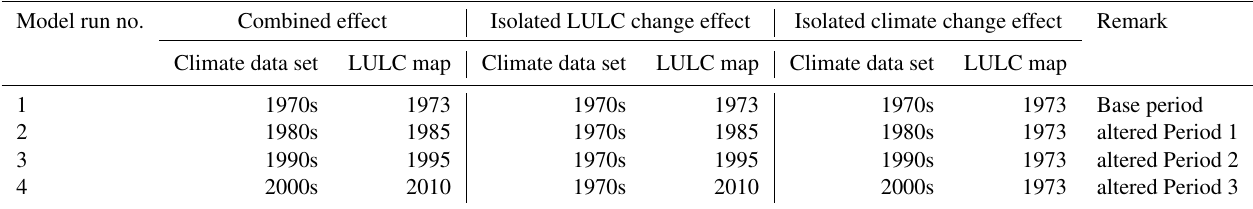
Table 2. Data sets of the baseline and altered periods for the SWAT simulation used to analyse the combined and isolated effect of LULC and climate change on streamflow and water-balance components. Model run